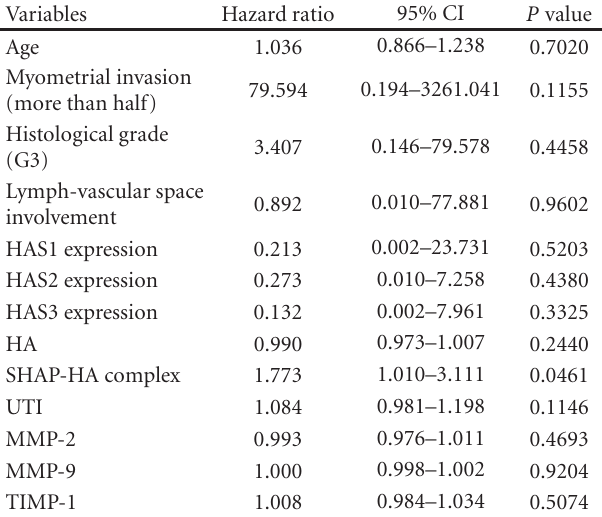
Table 6: Hazard ratios for disease-free survival with 95% CIs ad- justed for HAS, HA, SHAP-HA complex, UTI, MMP-2, MMP-9, TIMP-1, and the clinicopathologicalmanifestationsin patients with endometrial